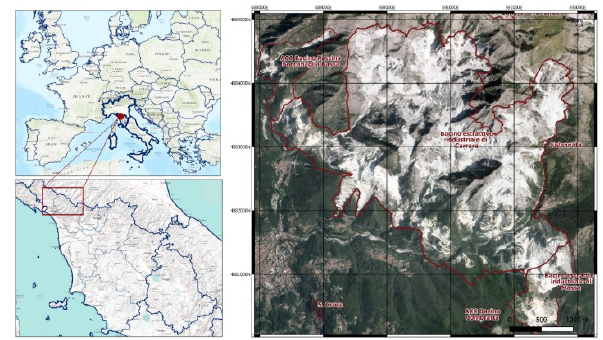
Figure 1 . Carrara industrial basin (44°05'53'' N - 10°07'44'' E – WGS84): 1:50.000 general view. Background: 2019 orthoimage.